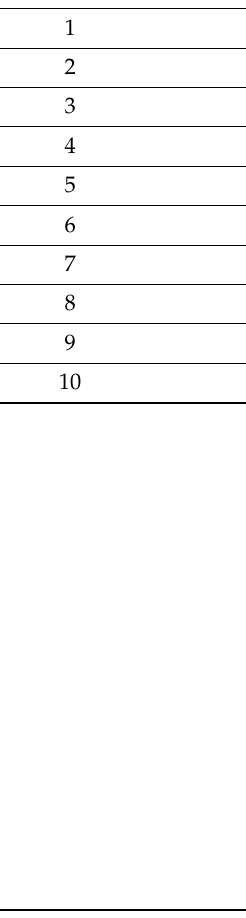
Table 4. CHAdeMO pinout functionalities [32].